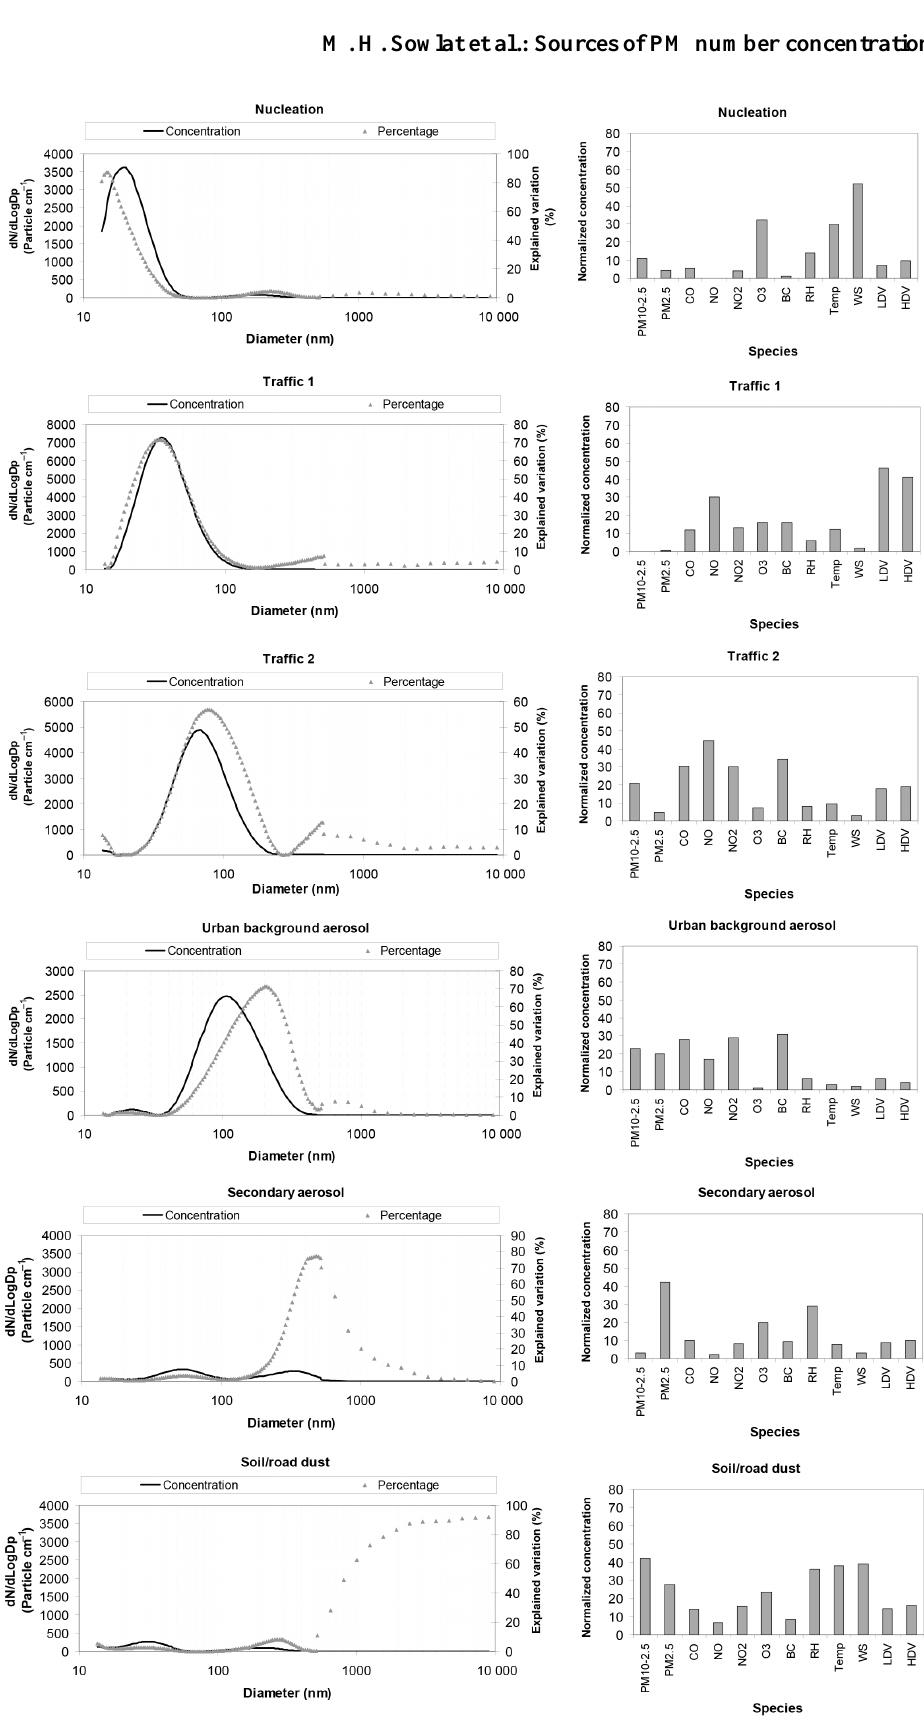
Figure 3. The number size distributions as well as the auxiliary variables profiles for each of the factors resolved by the PMF